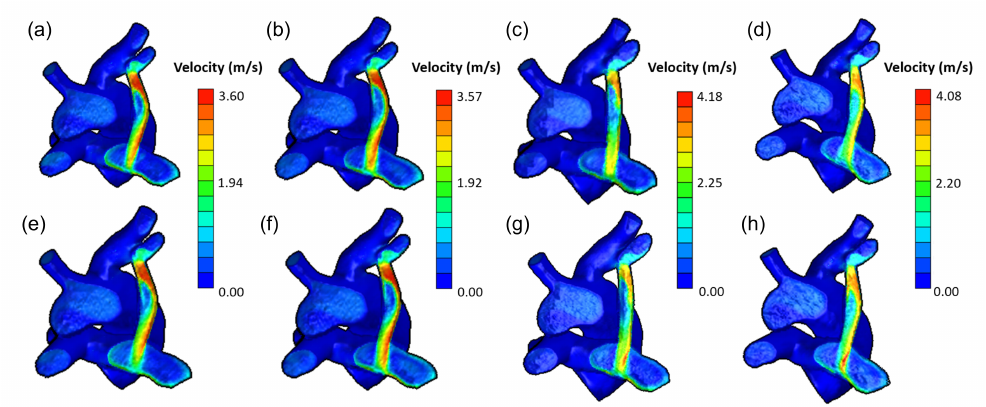
Figure 6. Velocity map comparison of the shunt’s longitudinal cross-section between the CFD ( a – d ) and the ROM ( e – h ) flow field ( e – h ) for four different validation scenarios: No. 135 ( a – e ), No. 1 ( b – f ), No. 34 ( c – g ), No. 146 ( d – h ).